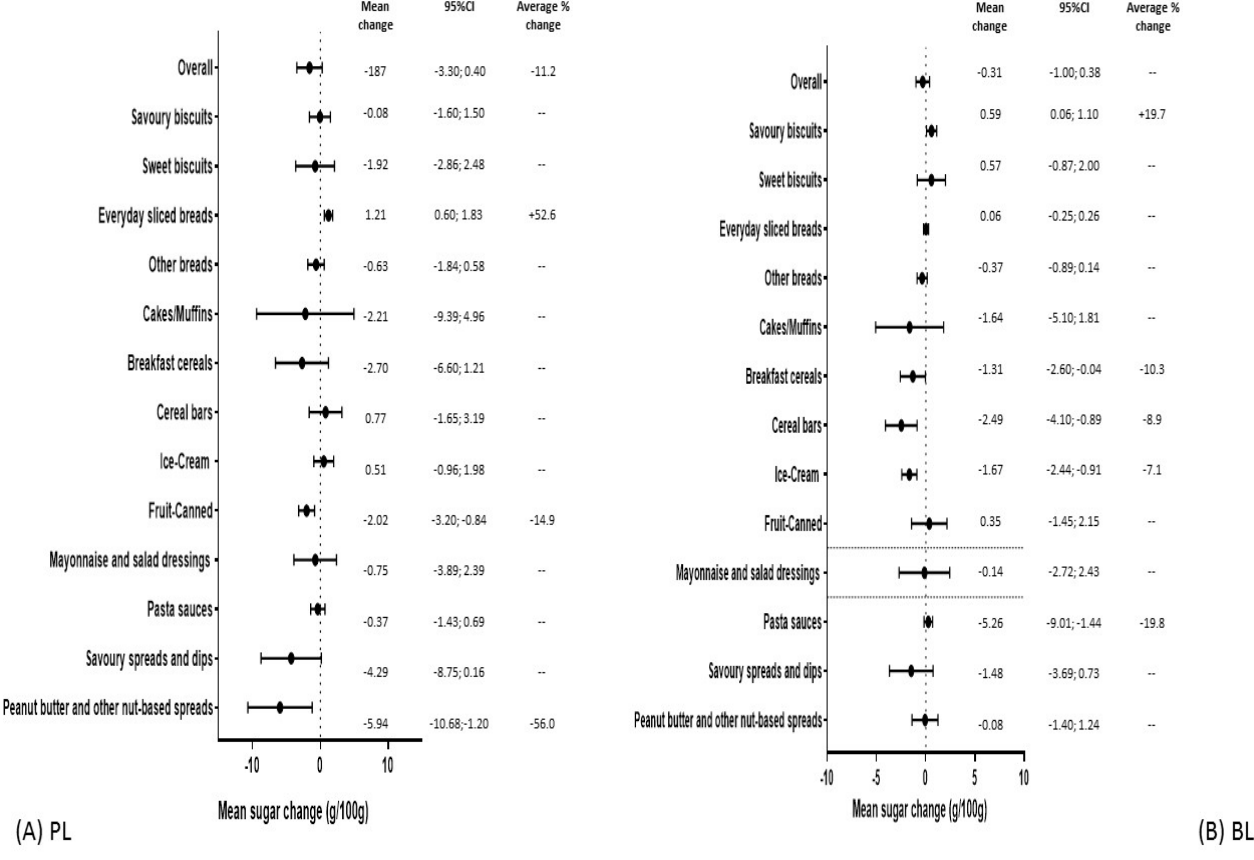
Figure 2. Mean sugar changes in the period 2015–2019 according to brand (overall and by food categories): supermarket private labels ( A ) and branded labels ( B ).